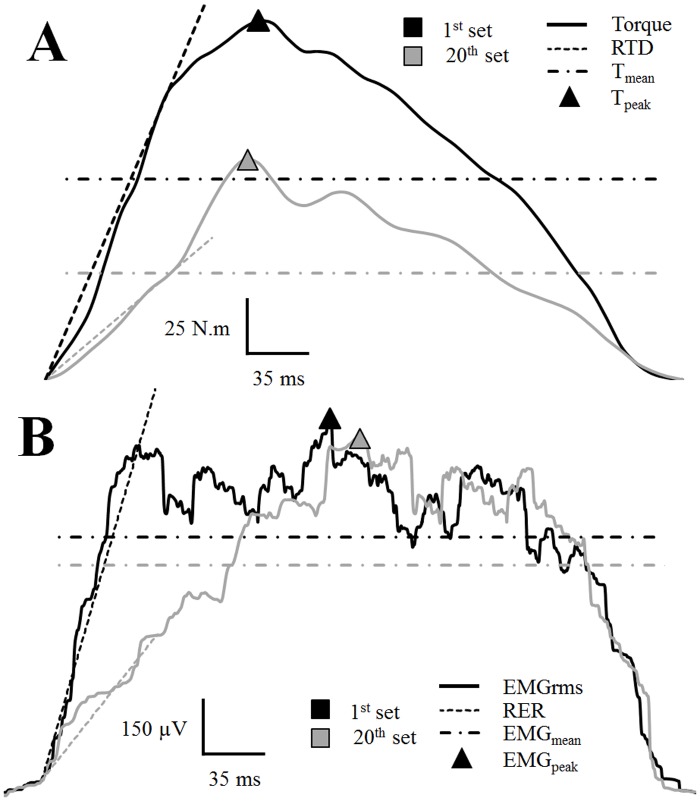
Torque and EMG signals recorded at the start and end of the exercise protocol.A- Illustration of typical changes in average torque traces recorded during set 1 (black line) and set 20 (grey line) and associated changes in the torque variables extracted: Tmean (dash-dotted lines), Tpeak (triangles) and RTD (dotted lines). B—Illustration of the typical changes in average EMG RMS signal of VL muscle recorded during set 1 (black line) and set 20 (grey line) and associated changes in the EMG variables extracted: EMGmean (dash-dotted lines), EMGpeak (triangles) and RER (dotted lines).